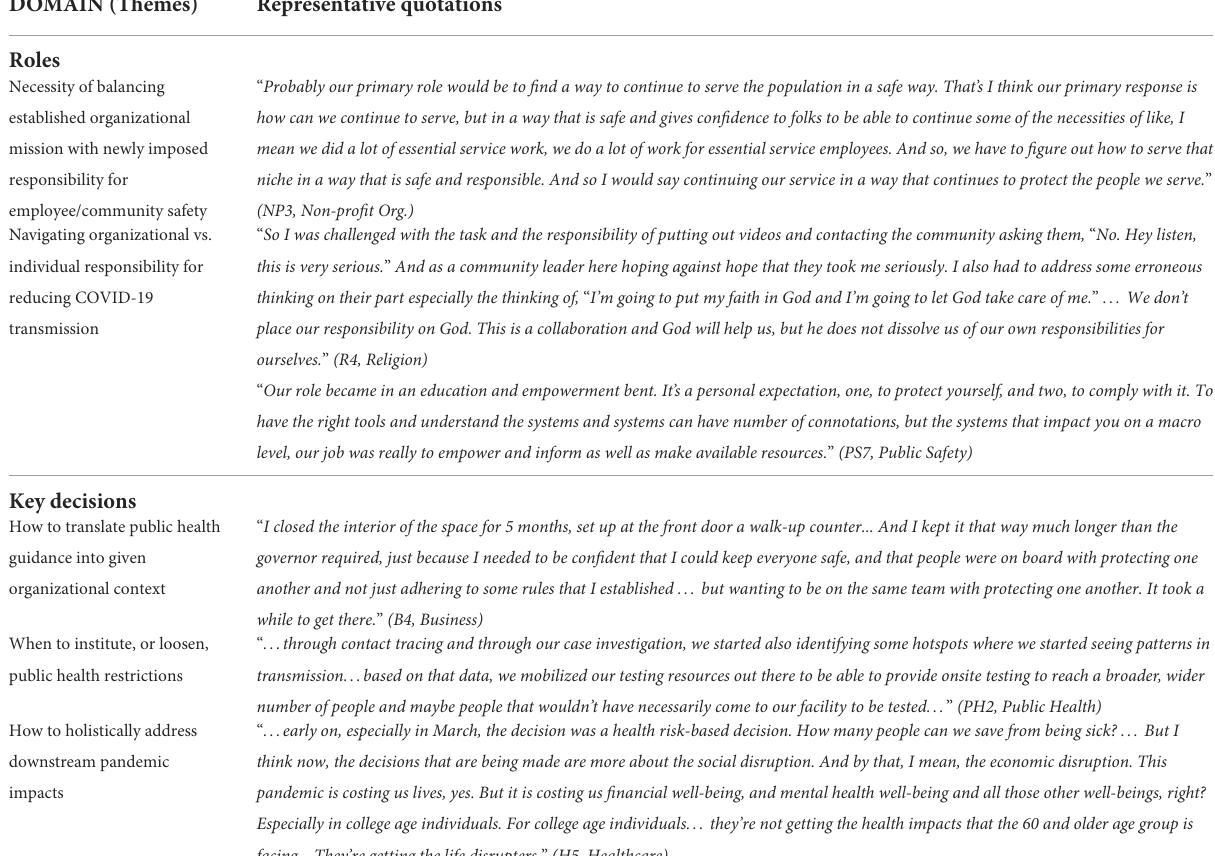
TABLE 2 Decision landscape themes and representative quotations. DOMAIN (Themes) Representative